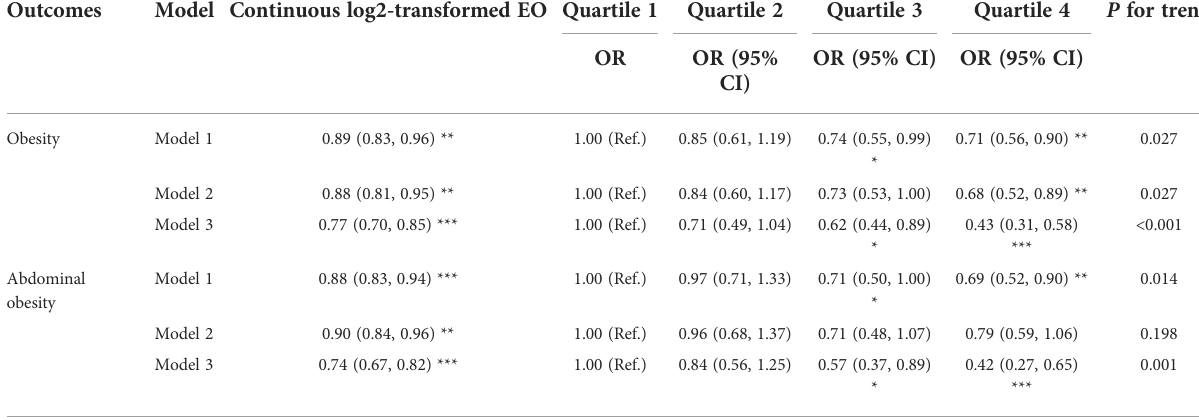
TABLE 3 Multiple logistic regression associations of HbEO with obesity and abdominal obesity in adults. Outcomes